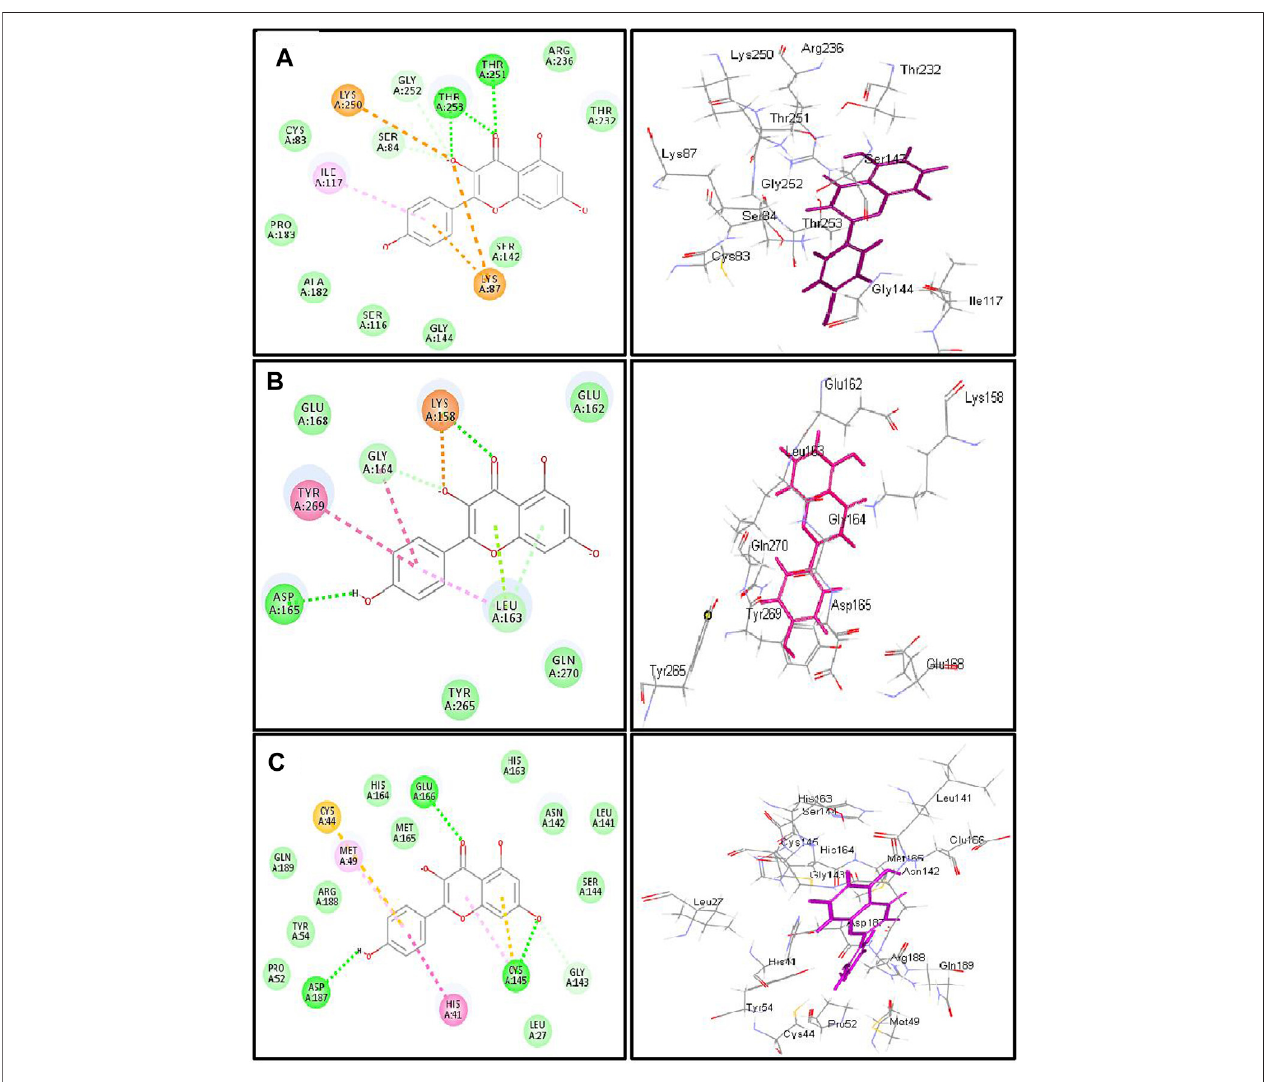
FIGURE 6 | 2D and 3D binding modes of kaempferol in the active centers of (A) β -lactamase (B) SARS-CoV-2PLpro and (C) SARS-CoV-2 3CLpro; dotted green lines indicate H-bonds; dotted light green lines indicate C-H-bonds; dotted purple lines indicate π -bonds; dotted orange bonds indicate salt bridge formation.